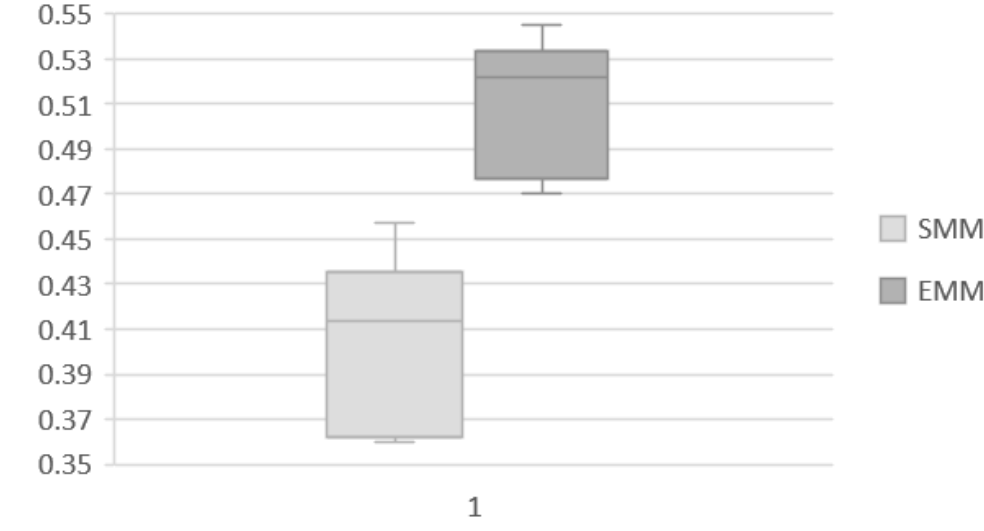
Figure 8. Box plot comparison of SMM and EMM fusion